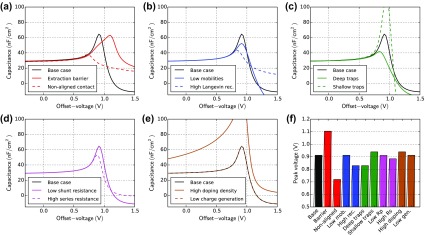
Capacitance-voltage simulations for all cases in Table 1 without offset illumination. The capacitance C is calculated according to Equation (20). The frequency is kept constant at 10 kHz. (f) Voltage where the capacitance reaches a maximum.